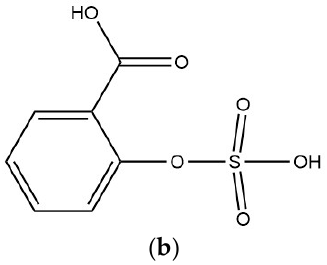
Figure 1. Schematic diagram of PANI and SSA molecules. ( a ) Molecular structure of polyaniline; ( b ) Molecular structure of sulfosalicylic acid.